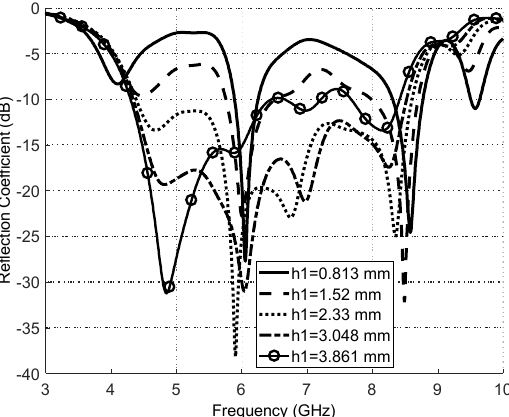
Figure 7. Predicted values of reflection coefficient ( S 11) with five different values of substrate height h 1 .